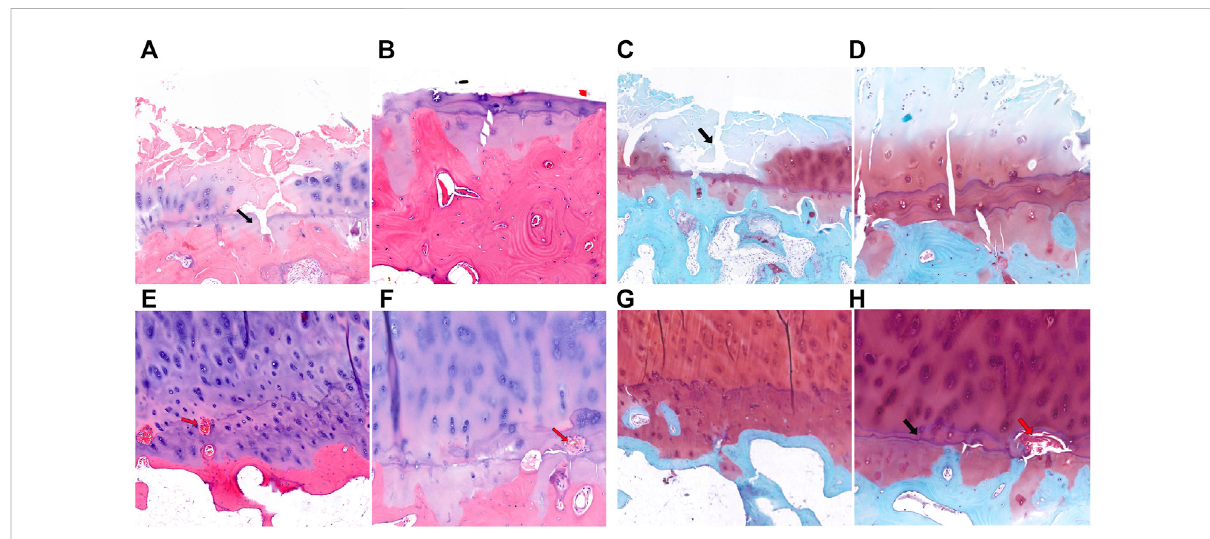
FIGURE 3 HEandsafraninO-fastgreenstainingofcartilageandsubchondralboneofthetibialplateauinOApatients. (A,B) ,HEstainingofthemedialtibial plateau. The black arrow shows a blurred tidemark and indistinguishable calci fi ed layer (magni fi cation: (A) , ×5; (B) , ×10). (C,D) , Safranin O-fast green staining of the medial tibial plateau. The black arrow shows adefect of cartilage(magni fi cation: (C) , ×5; (D) , ×10). (E,F) , HE staining of thelateral tibial plateau.The red arrowshows vascular invasion (magni fi cation: (E) ,×5; (F) , ×10). (G,H) ,SafraninO-fastgreenstainingofthelateral tibialplateau. The black arrow shows tidemark replication, and the red arrow shows vascular invasion (magni fi cation: (G) , ×5; (H) ,